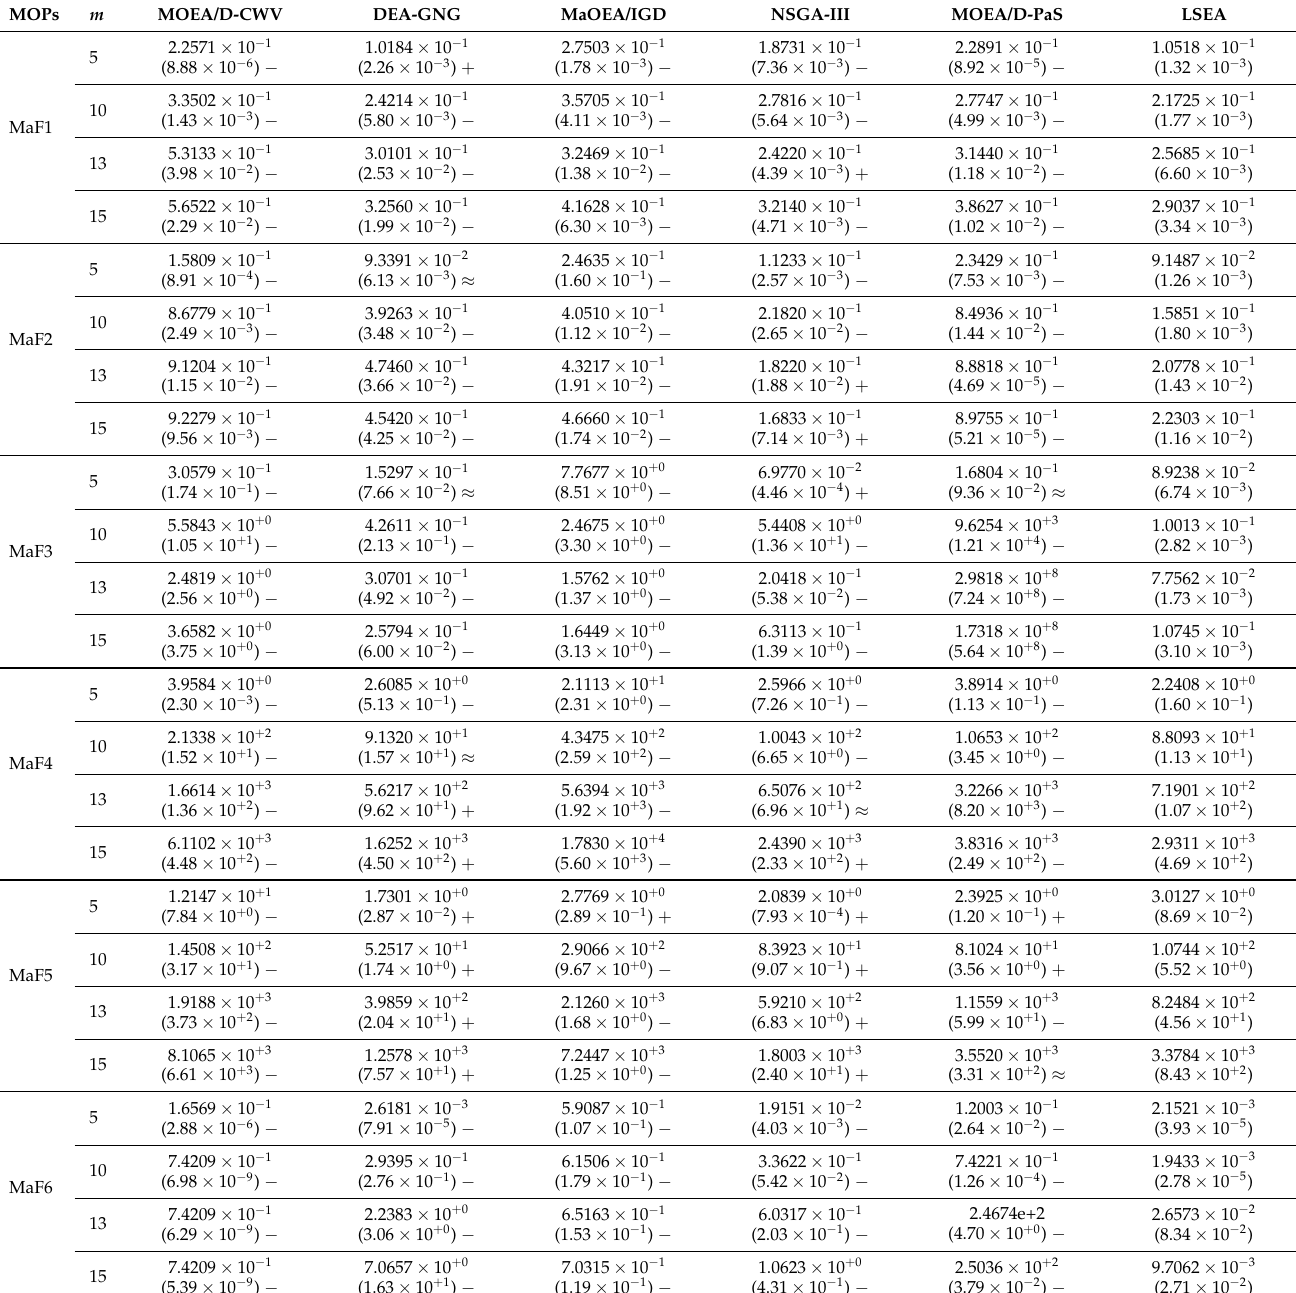
Table 2. IGD values (average and standard deviation) obtained by the LSEA and the five baselines on the MaF1-MaF9 with 5, 10, 13, and 15 objectives. The lowest average IGD value on each test instance is highlighted with a gray